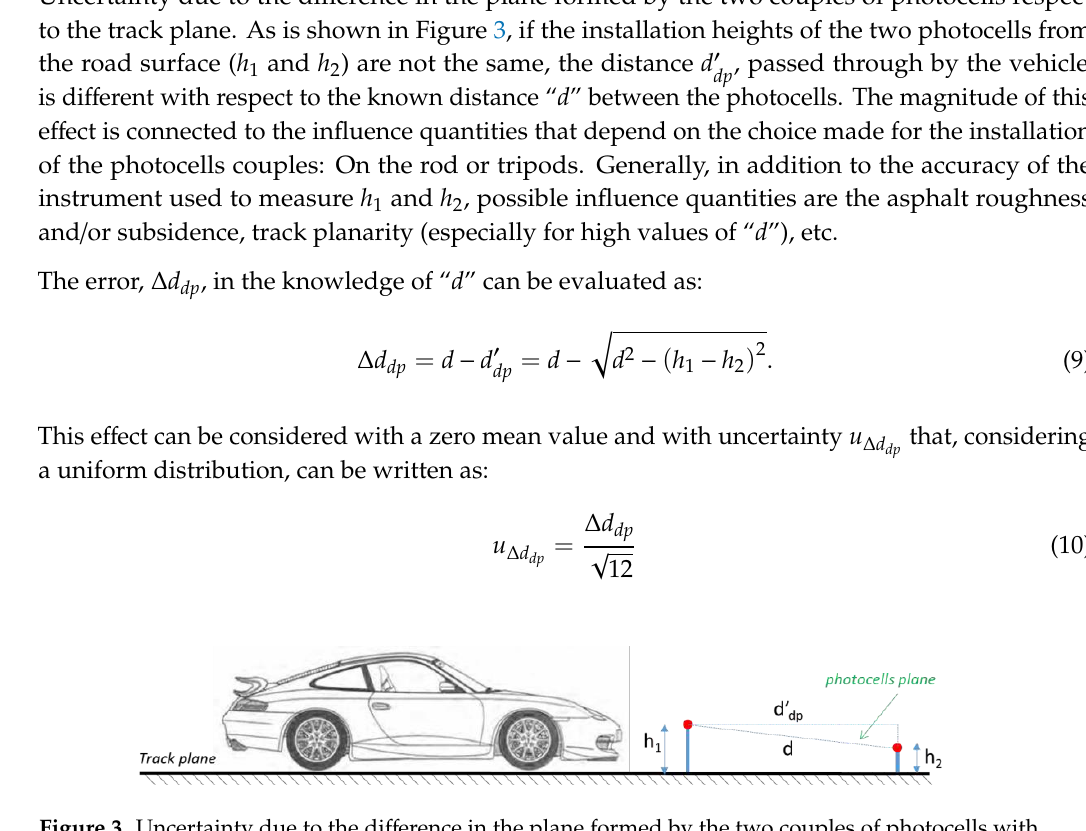
Figure 3. Uncertainty due to the difference in the plane formed by the two couples of photocells with respect to the track plane.